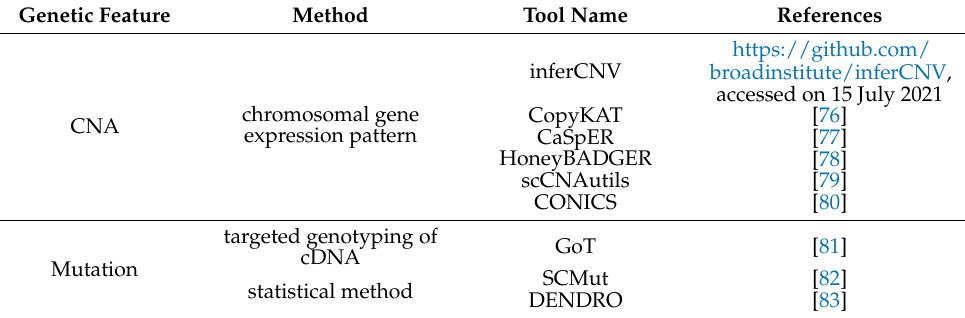
Table 4. Genetic features assessed by scRNA-seq. Genetic Feature